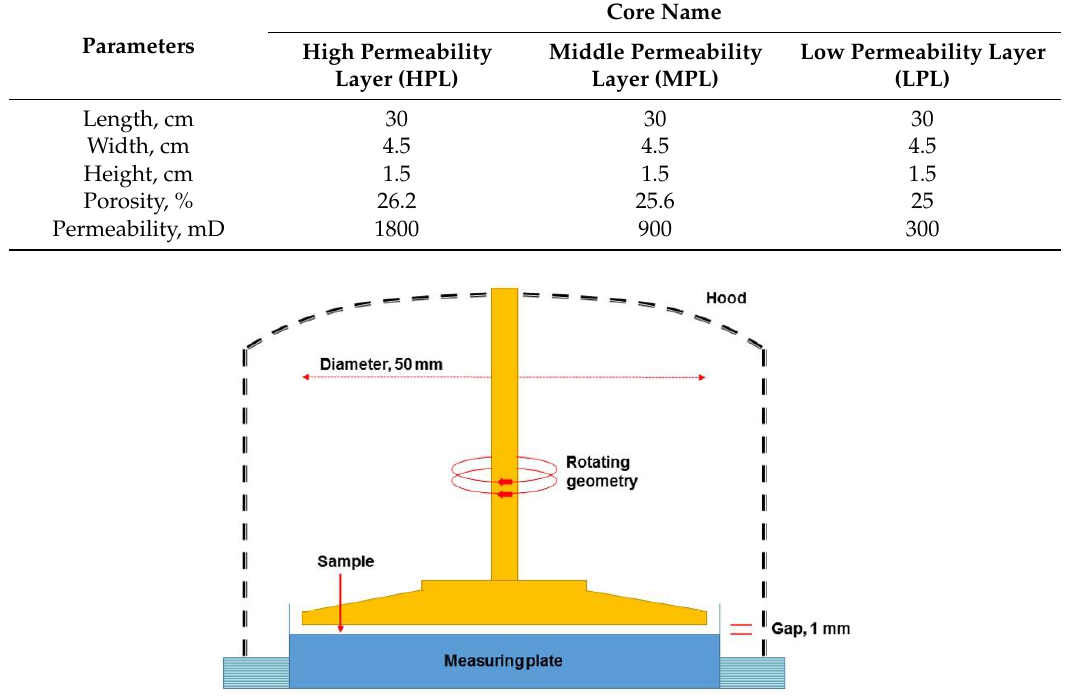
Table 5. Parameters of core samples used to perform polymer flooding experiment.